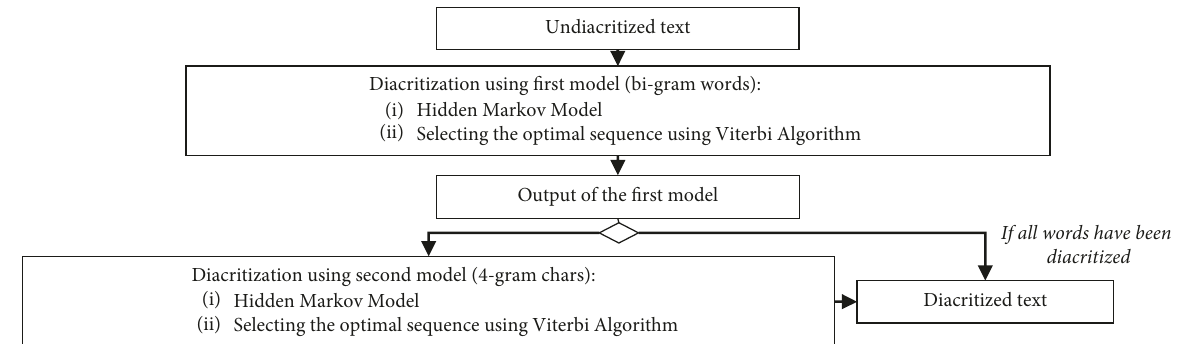
Figure 1: Vocalization system using hidden Markov model